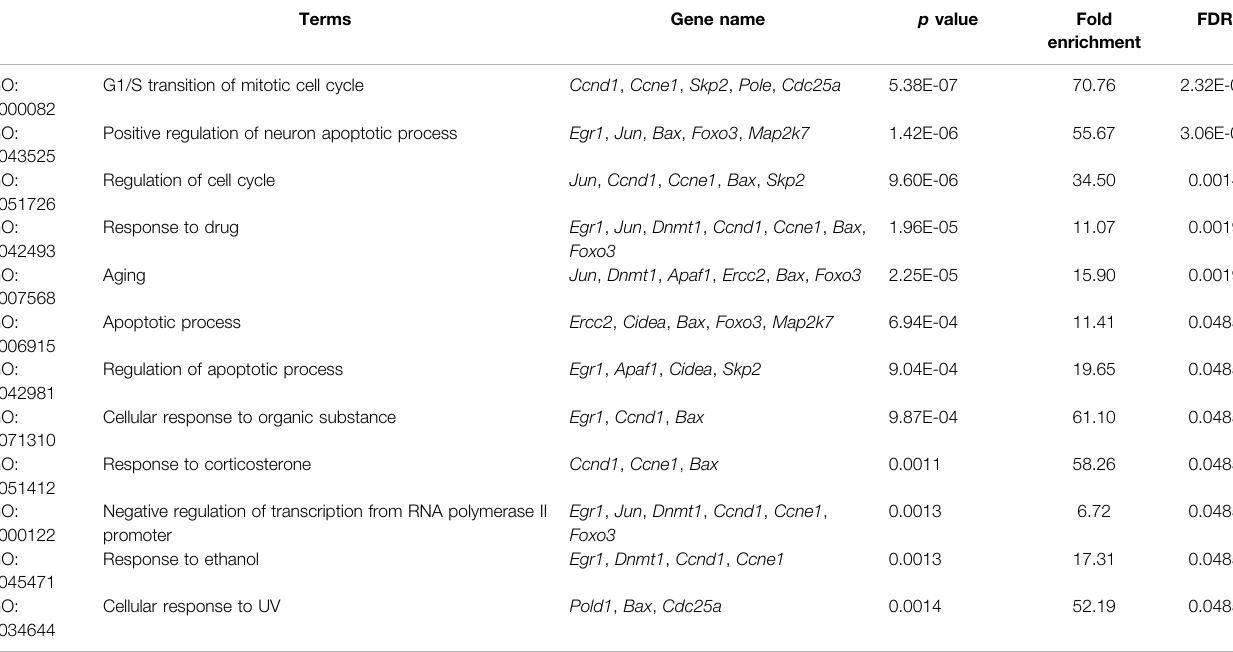
TABLE 5 | Enriched biological process by differential genes expressed in the female offspring mammary gland of LPD 35